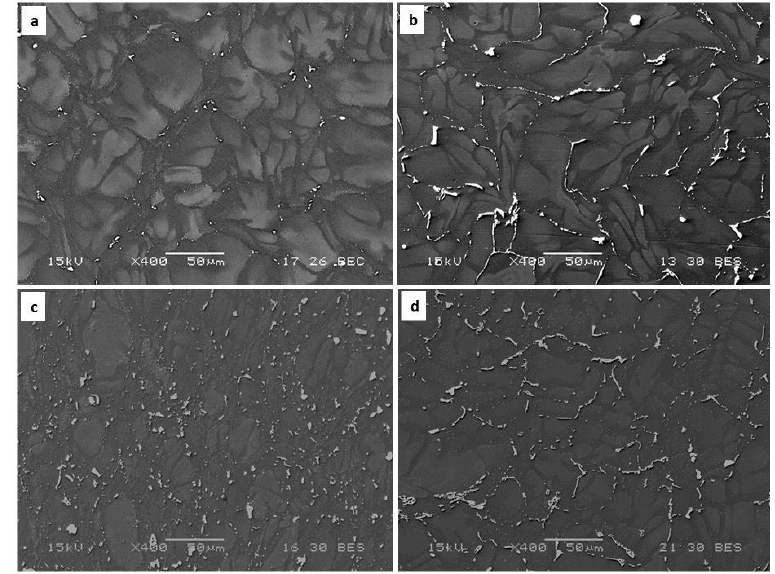
Figure 2. Typical microstructure obtained by scanning electron microscopy (SEM-BSE images) of ( a ) Mg-5%Zn, ( b ) Mg-5%Zn-1%Nd, ( c ) Mg-5%Zn-2%Nd, ( d ) Mg-5%Zn-3%Nd.